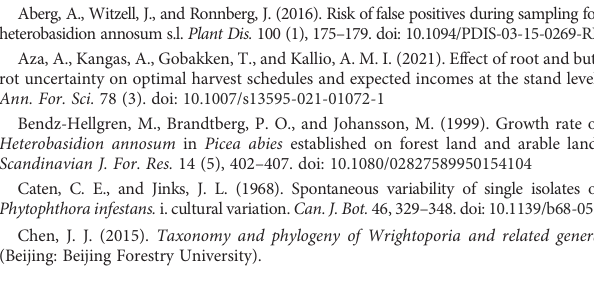
SUPPLEMENTARY FIGURE 1 The LAMP assay at different temperatures. The negative control was performed at 63°C for 60 min. SUPPLEMENTARY FIGURE 2 The LAMP assay at different times. The negative control was performed at 63° C for 60